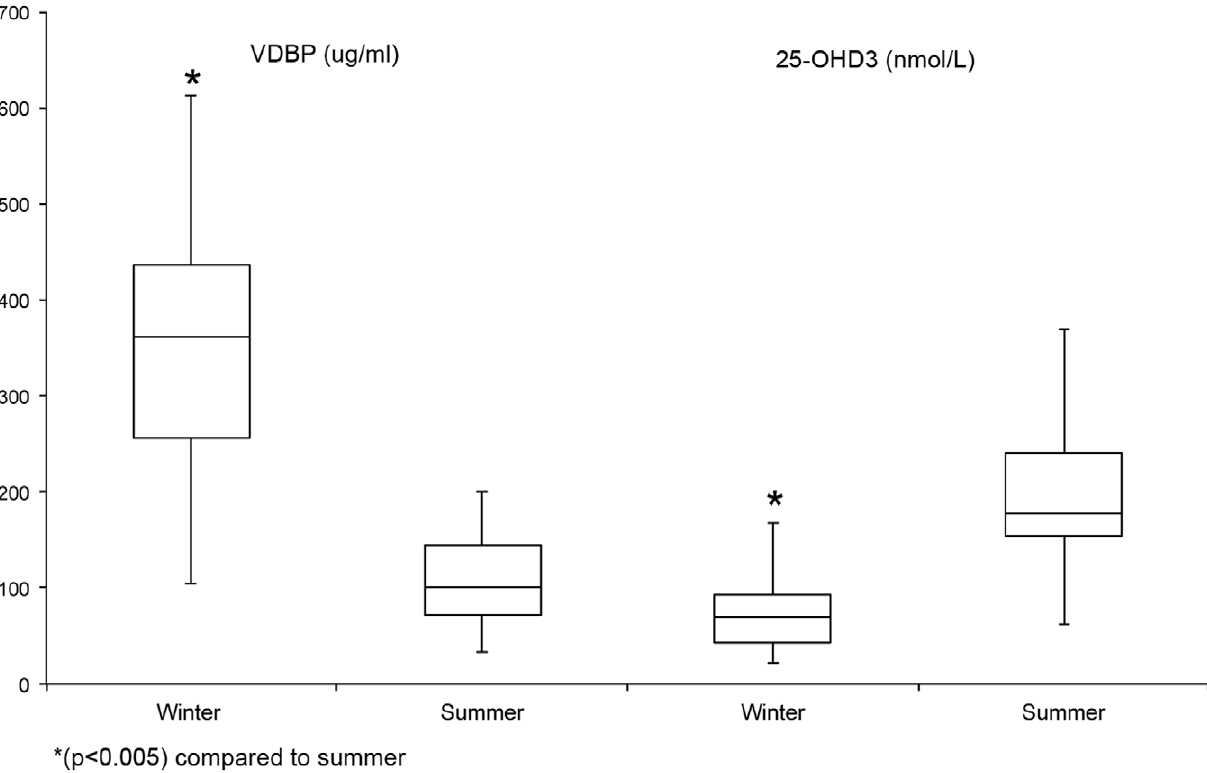
Figure 1. Seasonal comparison of the serum concentrations of VDBP (ug/ml) and 25-0HD 3 (nmol/L). The mean serum concentration of VDBP was significantly lower in the summer. The mean serum concentration of 25-OHD 3 was significantly higher in the summer. The concentrations of VDBP and 25-OHD 3 were inversely correlated. doi:10.1371/journal.pone.0049872.g001 PLOS ONE |